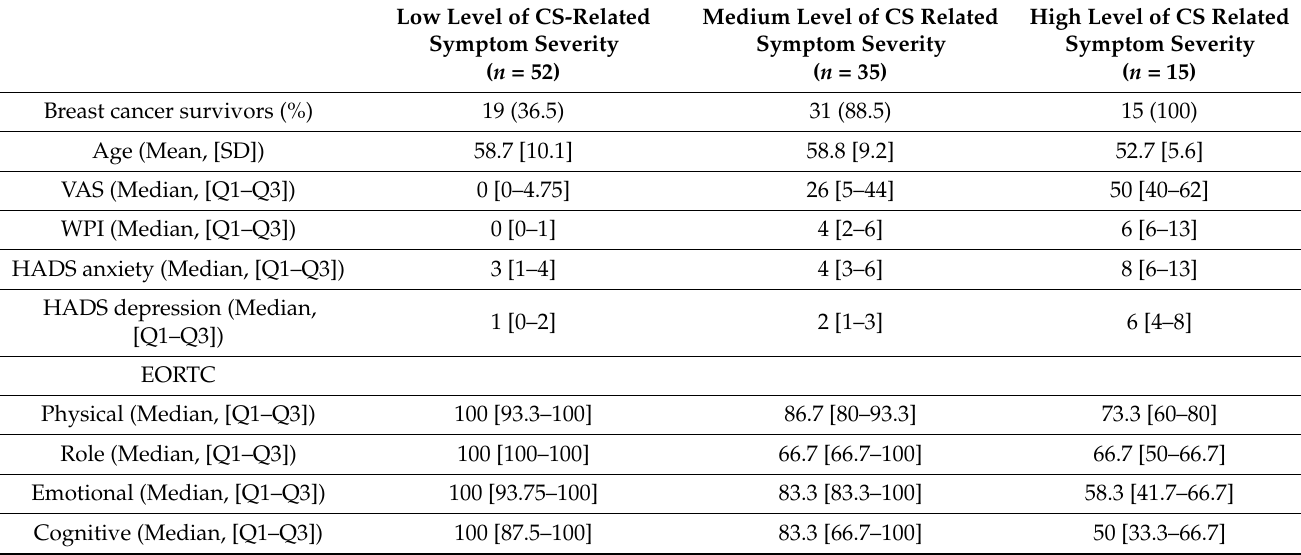
Table 3. Clusters characteristics ( n =